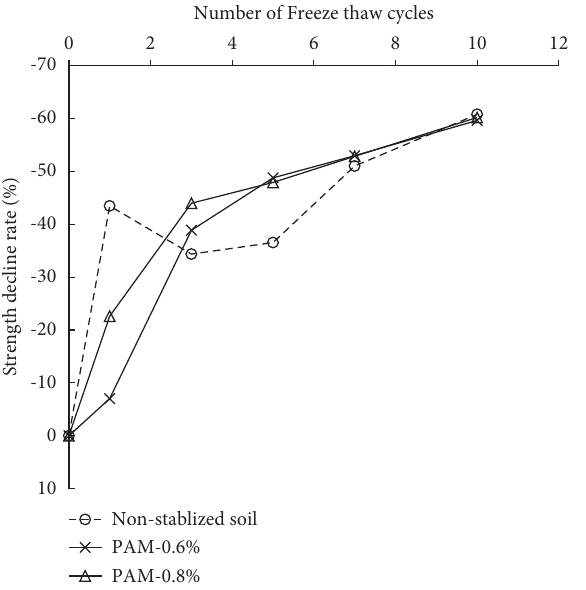
Figure 21: Changes of strength decrease of PAM (high content) stabilized specimens with freeze-thaw